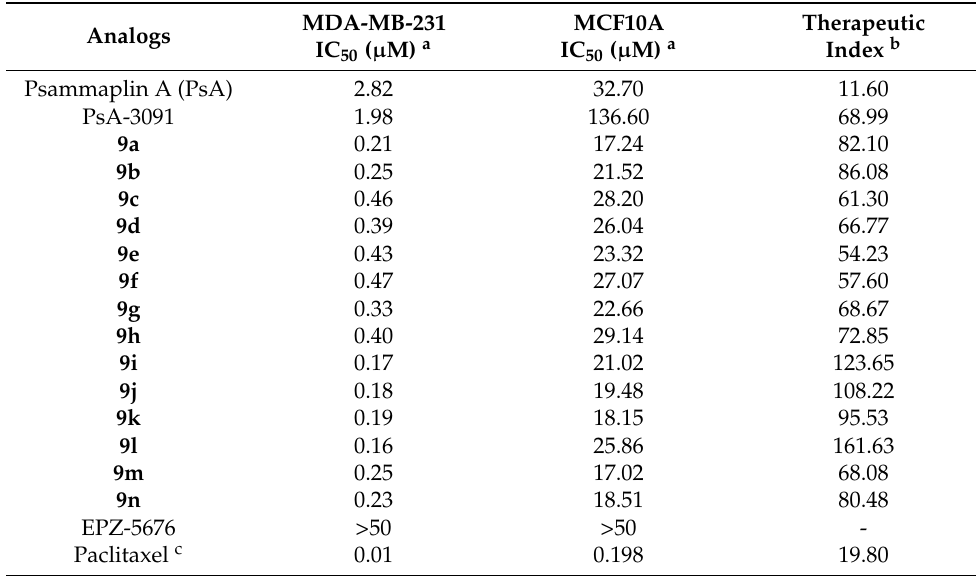
Table 2. Antiproliferative activities of HSPA analogs against TNBC cell